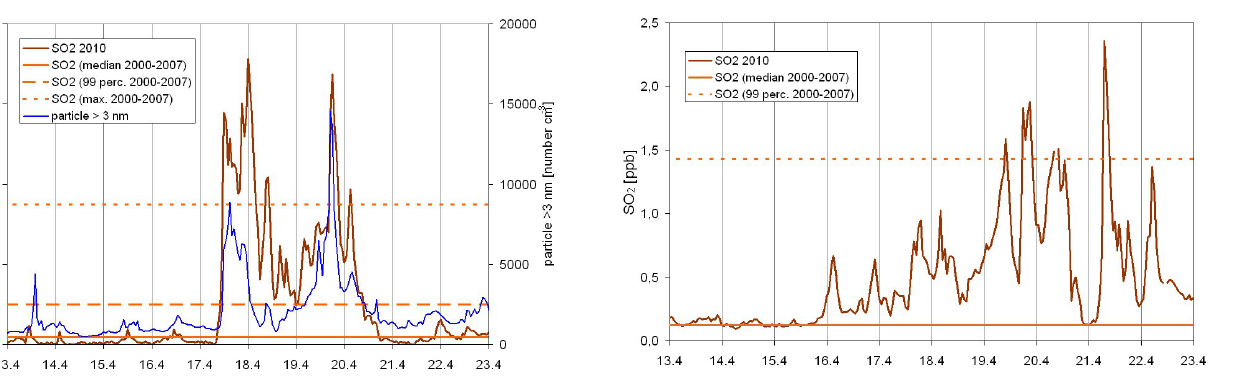
Fig. 3. SO 2 mixing ratios and particle number concentra- tions ( > 3nm) measured by DWD at the GAW Global Station Zugspitze/Hohenpeissenberg, platform Zugspitze/UFS at 2650 m elevation. The particle number concentrations are highly correlated with SO 2 . The continuous and dashed red lines indicate the median, the 99-percentile and the maximum observed (year 2000–2007) val- ues of the SO 2 mixing ratios at “Schneefernerhaus”.